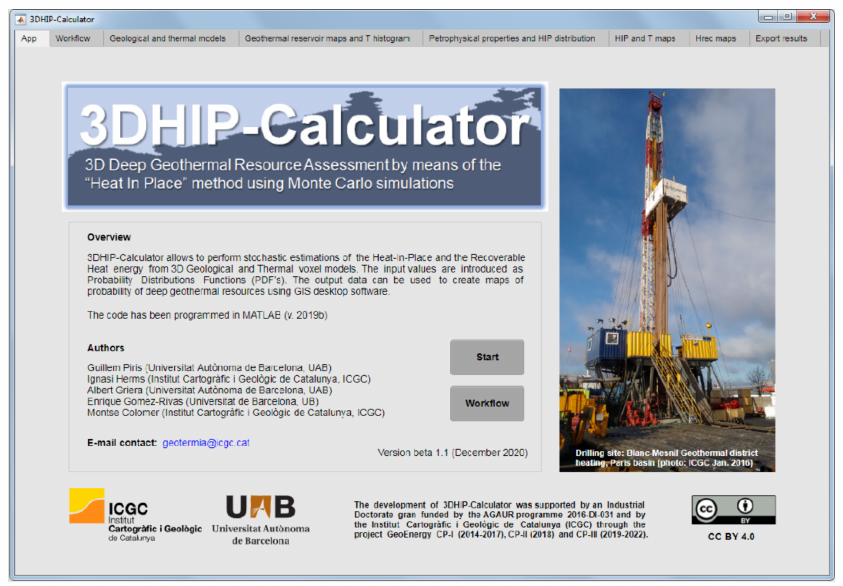
Figure 1. Screenshot of the main GUI window. The 3DHIP-Calculator is organized in eight tabs.